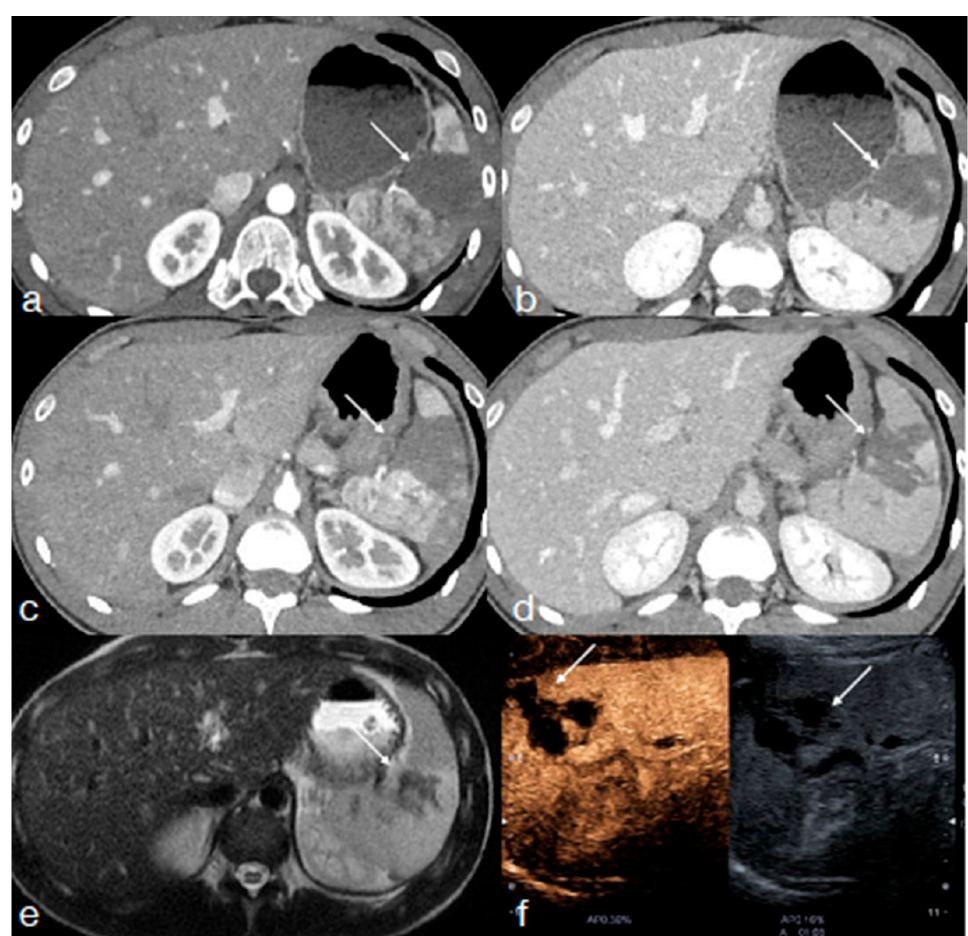
Figure 4. Twenty-year-old male patient underwent high-energy left-flank trauma with high-grade spleen injury, AAST IV: ( a , b ) enhanced CT upon admission for arterial ( a ) and portal ( b ) phases showing the spleen laceration (( a , b ) arrows). Due to the high-grade splenic injury, the patient was re-evaluated at 24 h by enhanced CT (( c ) arterial phase and ( d ) portal phase, arrows) and subsequently at 1 week by MRI (( e ) T2W Fat Sat sequence in axial plain showing the splenic laceration, arrow) and five more days later by CEUS (( f ) arrows), demonstrating the progressive healing of the laceration without evidence of vascular injuries.